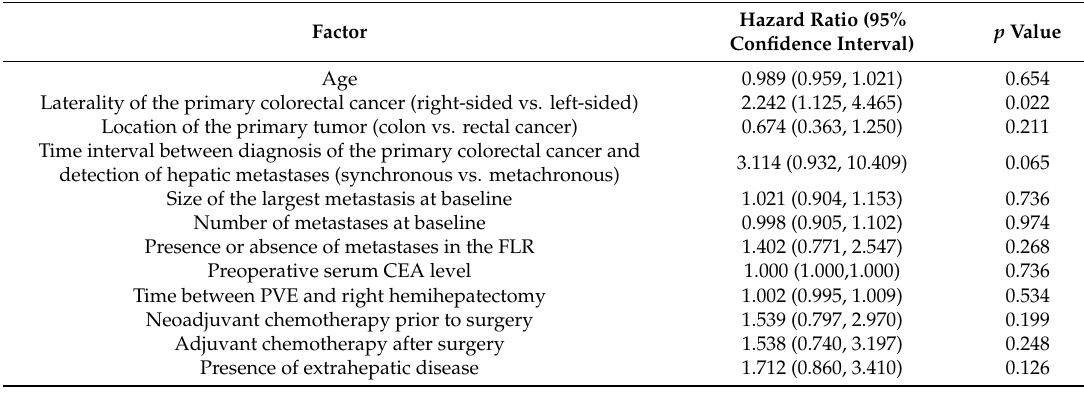
Table 2. Results of the univariable Cox regression analysis for intrahepatic progression-free survival. CEA: carcinoembryogenic antigen, PVE: portal vein embolization.